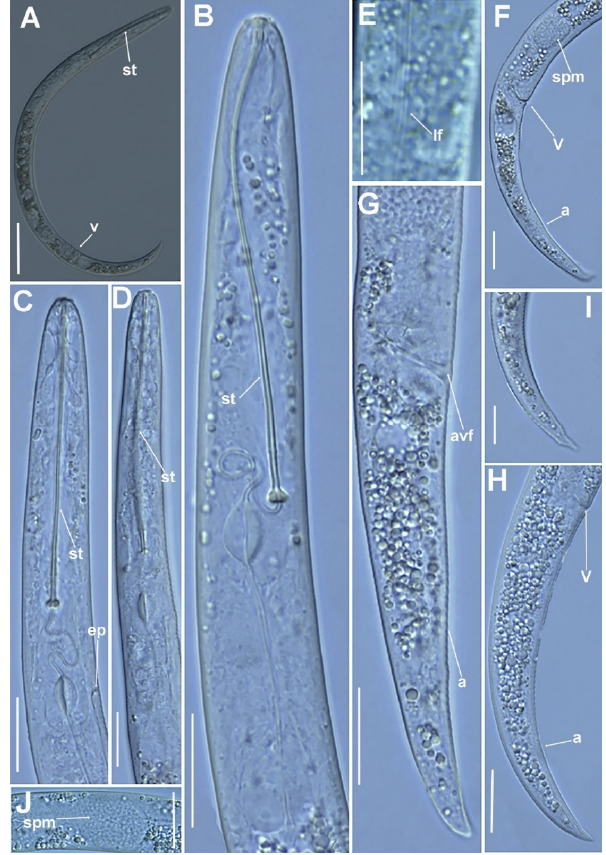
Figure 1. Line illustrations of Paratylenchus paraaonli sp. nov. ( A ) Whole female body; ( B ) Female pharyngeal region; ( C ) Detail of lateral field at mid-body; ( D ) Female posterior region; ( E , F ) Female tail.